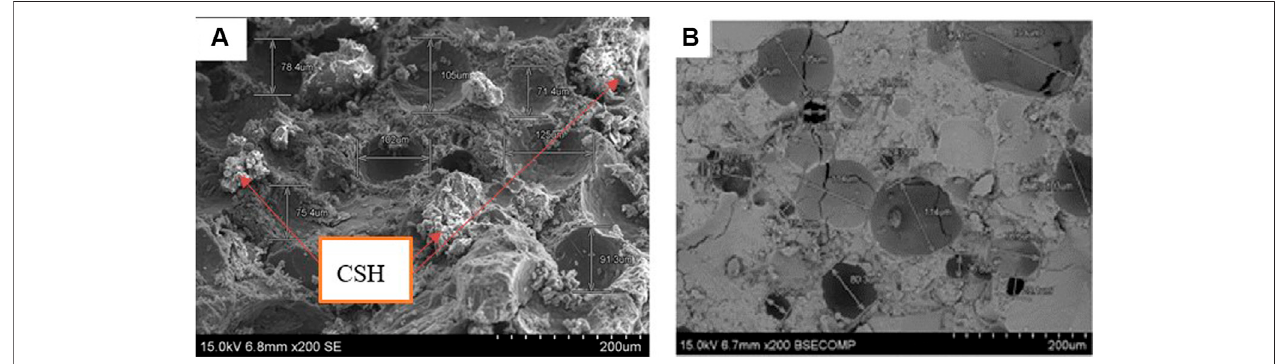
FIGURE 11 | Microstructure of lightweight foamed concrete with and without 50% ceramic tile waste powder. (A) LFC with 50% ceramic tile waste powder. (B) Control LFC (without ceramic tile waste powder).